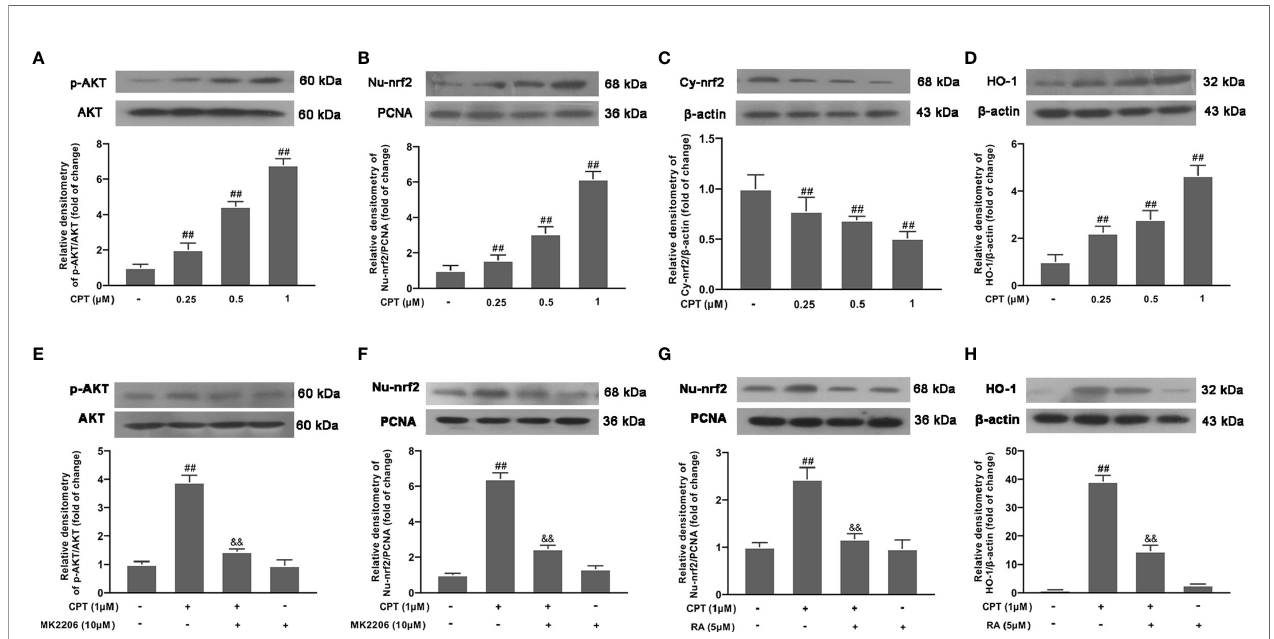
FIGURE 6 | CPT promotes phosphorylation of AKT, activation of Nrf2, and up-regulates the expression of HO-1. (A – D) After BV-2 cells were treated with CPT (0, 0.25, 0.5, and 1 m M) for 3 h, the phosphorylation of AKT and the protein levels of nuclear-nrf2, Cytoplasm-nrf2, and HO-1 were examined using western blot. (E, F) After the cells were treated with MK2206 (an AKT inhibitor, 10 m M) for 4 h and CPT (1 m M) for another 3 h, the protein levels of phos-AKT and nuclear-nrf2 were determined by western blot. (G, H) After BV-2 cells were treated with RA (a nrf2 inhibitor, 5 m M) for 4 h and CPT (1 m M) for another 3 h, the protein levels of nuclear-nrf2 and HO-1 were determined by western blot. Results are shown as means ± SD (n= 5). ## p < 0.01 vs. the no-treatment (NT)group; && p < 0.01 vs. the CPT-treated